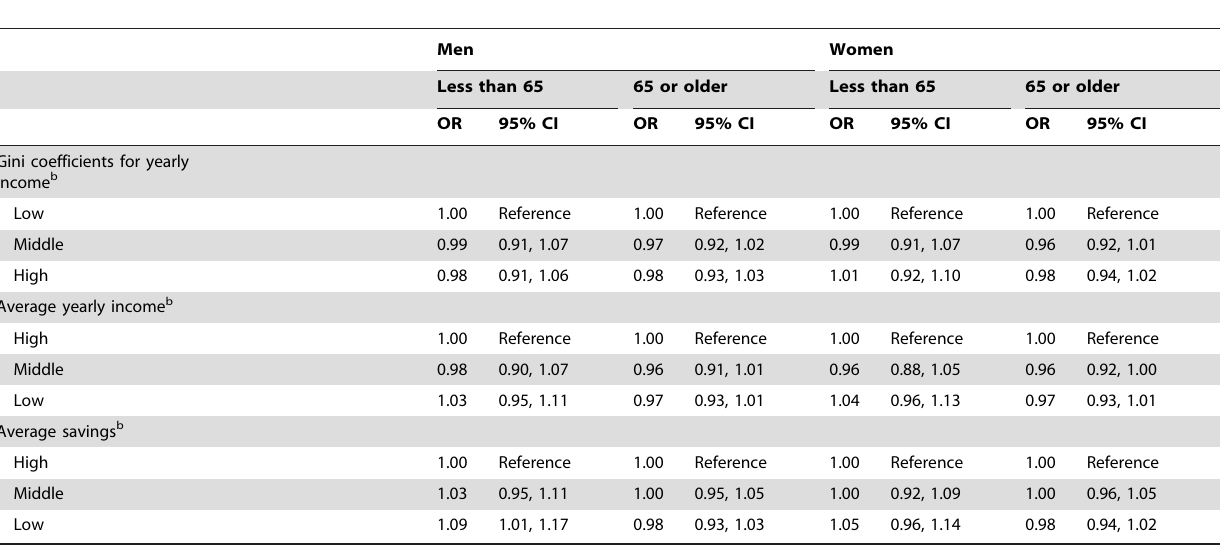
Table 3. Odds ratios for all-cause mortality associated with prefecture-level socioeconomic status variables when stratified by age, Japan, 2005 a .